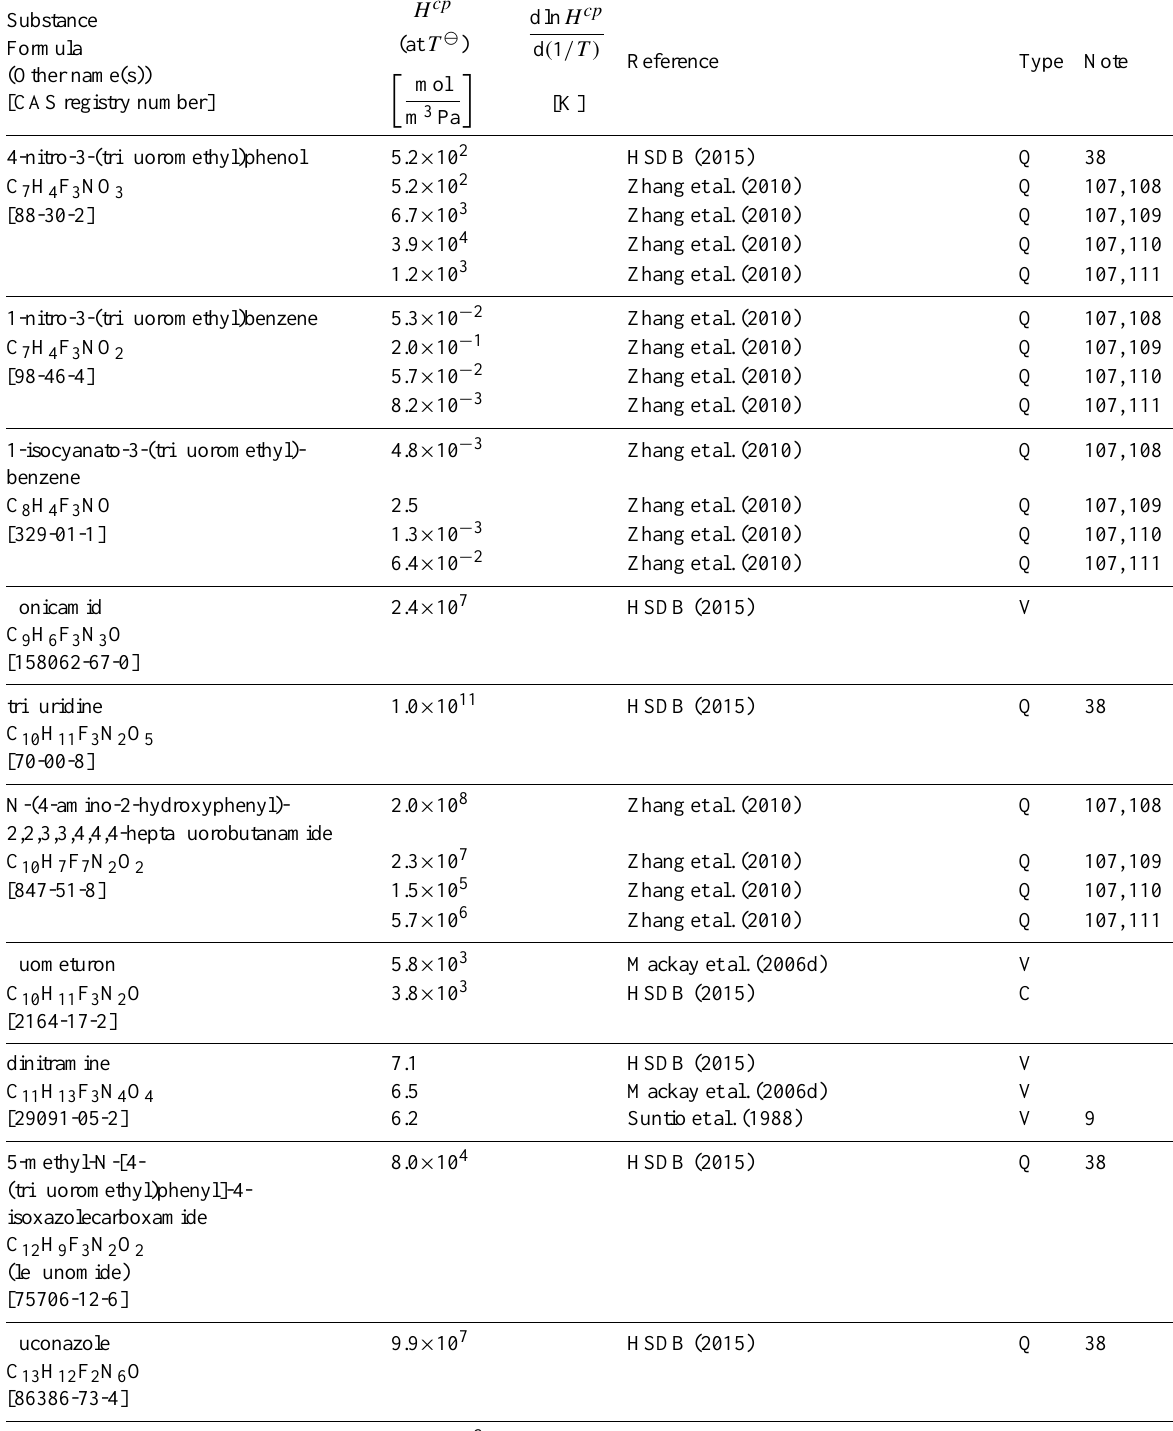
Table 6: Henry’s law constants for water as solvent